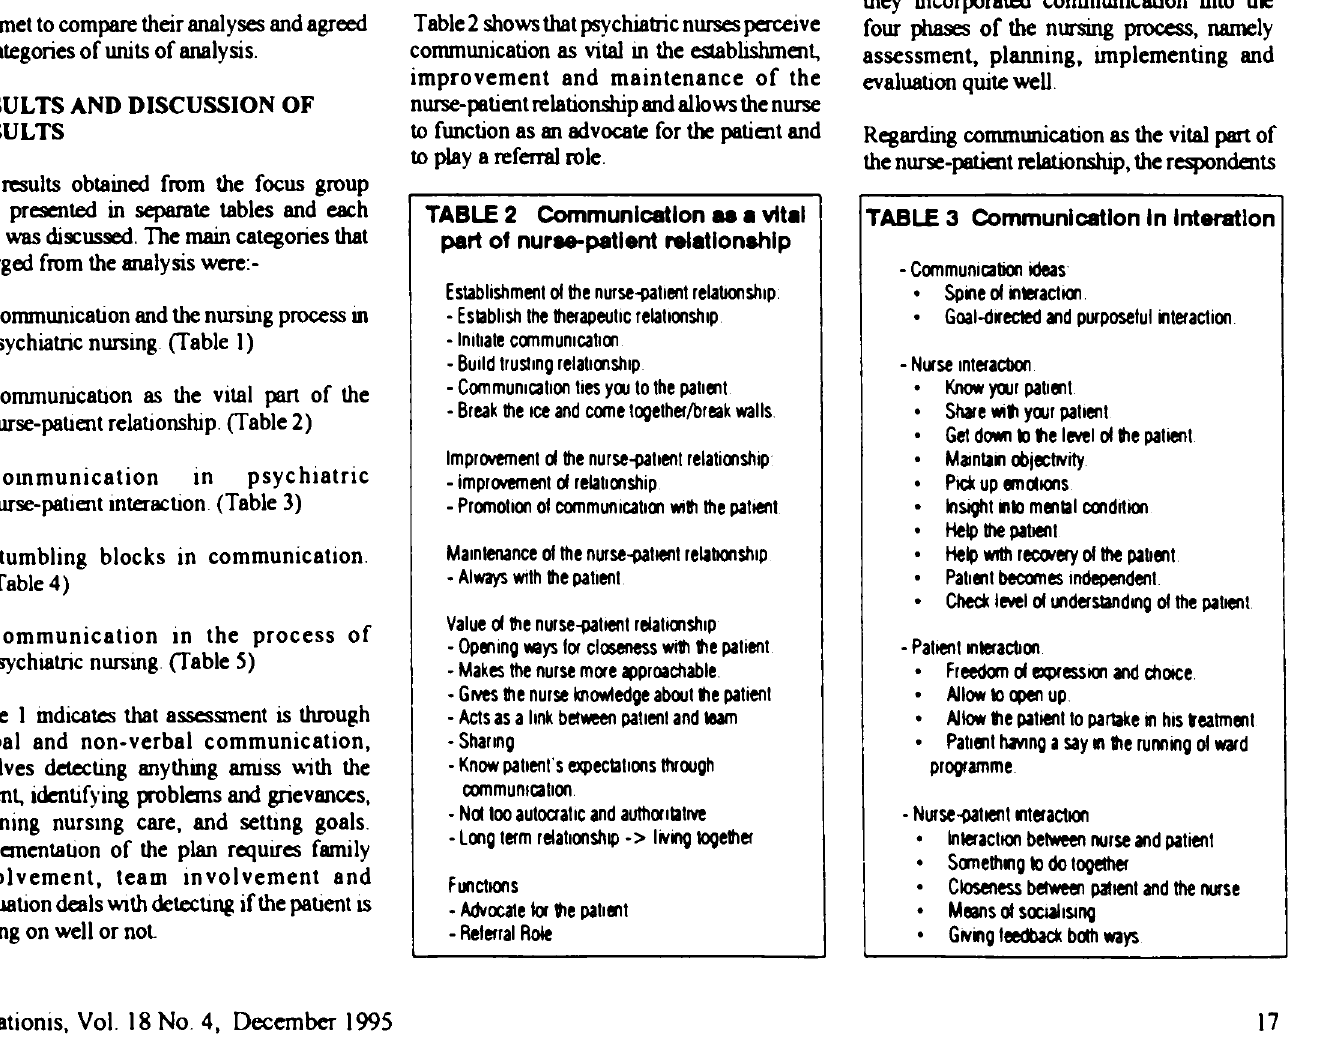
part of nurse-patient